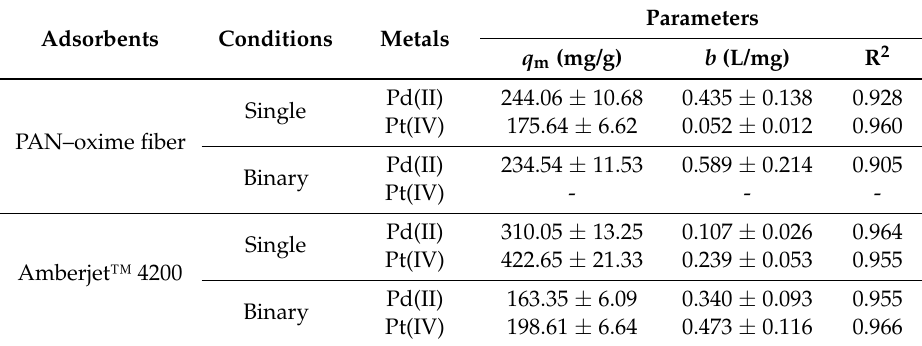
Table 1. Langmuir parameters in single and binary metal